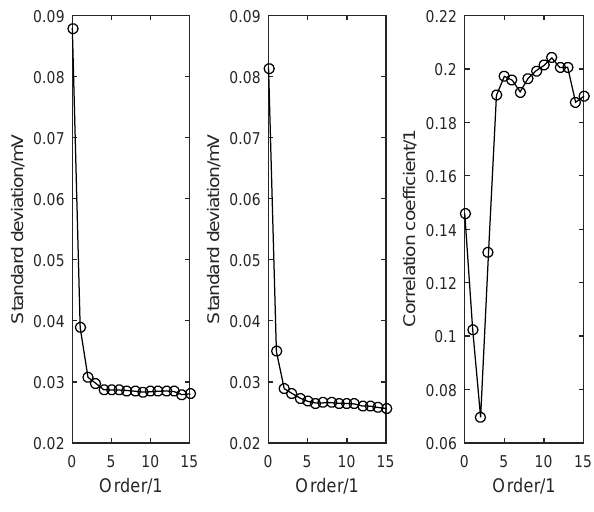
q Figure 7. Values of (left) the standard deviation b (cid:54) 11 , (middle) q the standard deviation b (cid:54) 22 , and (right) the correlation coefficient q b (cid:54) 12 / b (cid:54) 11 b (cid:54) 22 , derived from the covariance matrix b (cid:54) of a fitted AR noise model for different values of the order q of the